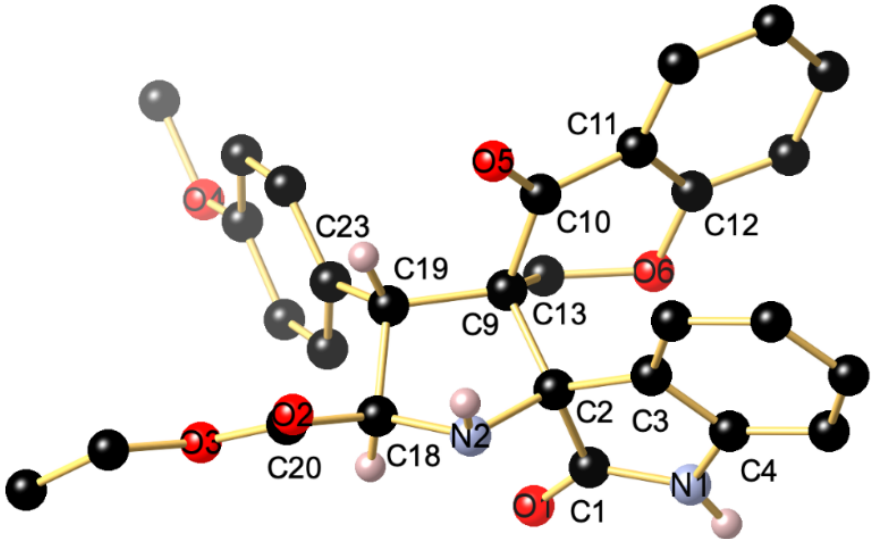
Figure 6. Ball and sticks presentation of the molecular structure of 9c recorded at 100 K. Only one of the two independent molecules is shown. Apart from stereochemically relevant H atoms, all other hydrogen atoms are omitted for clarity.